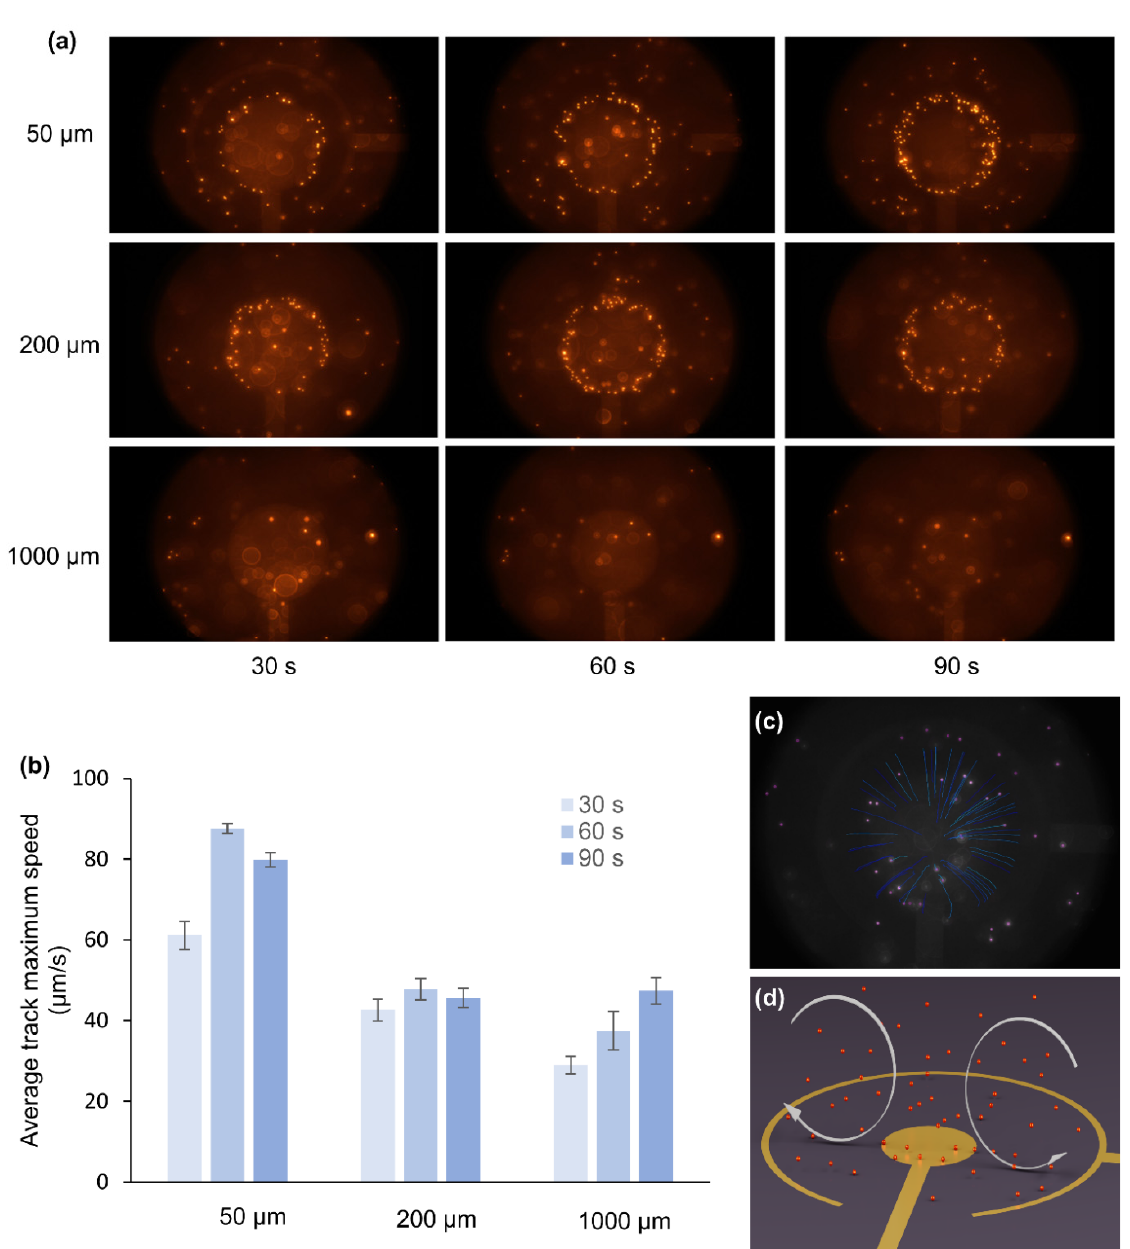
Figure 4. ( a ) Snapshots taken after 90 s of device operation in each case. ( b ) Average maximum speed in 2D devices calculated in intervals of 30, 60, and 90 s. The error bars show the calculation of the Average maximum speed from three ac-EHD devices in each case. ( c ) Snapshot from the particle tracking video obtained using NIH ImageJ software and Trackmate plugin (Video S4, Supplementary Materials). ( d ) Schematic of the ac-EHD driven fluid flow.